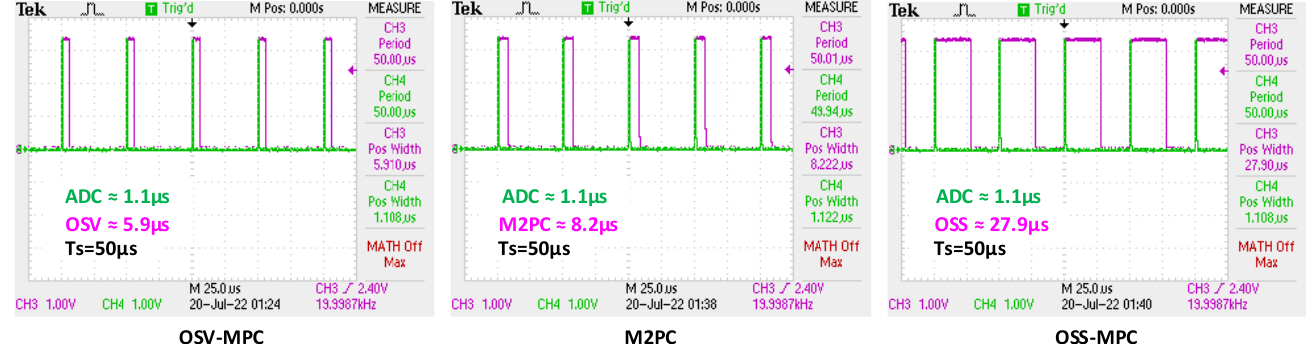
Figure 19. Comparison of ADC converter time and total computational time for each FCS-MPC technique.